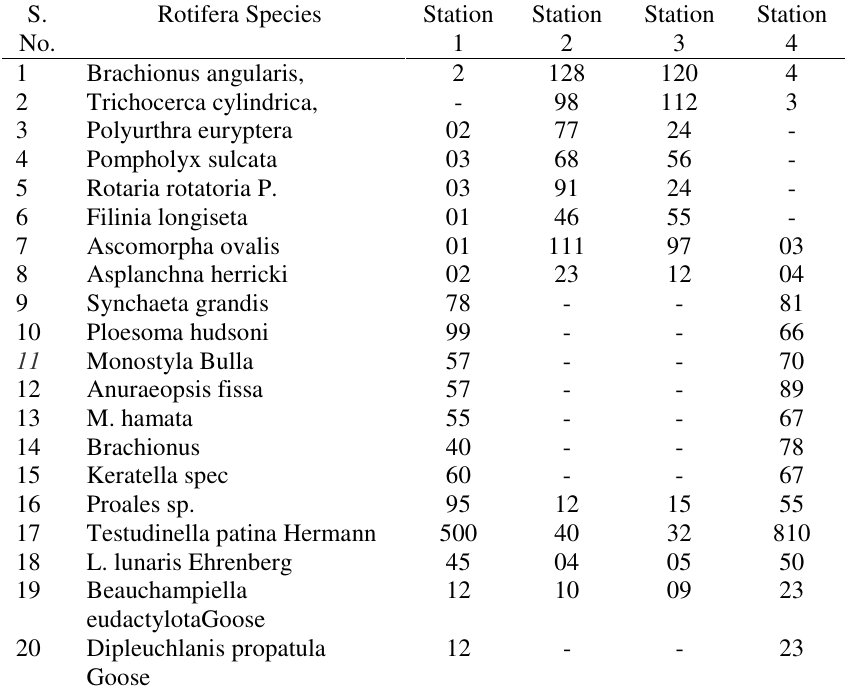
Table 2. Faunal comparision of Rotifera species in 4 stations of Cauvery